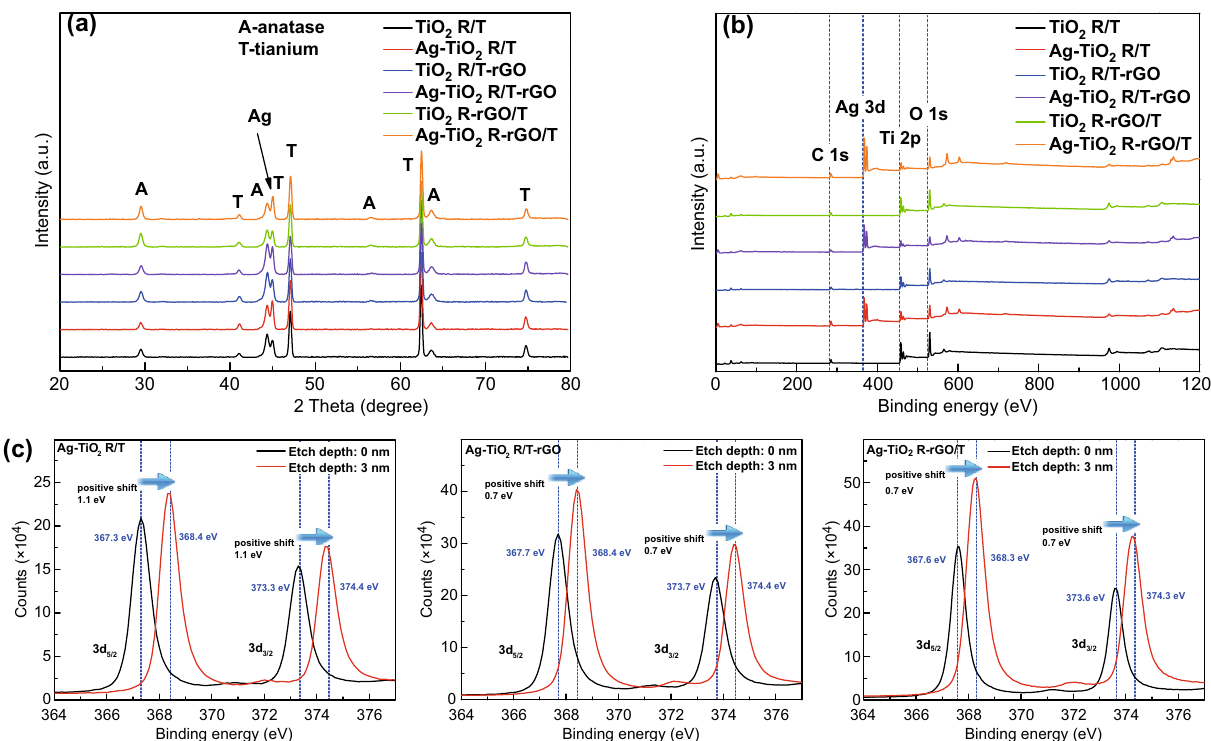
Fig. 1 a XRD patterns, b XPS full spectrum scanning, and c high-resolution XPS spectra of the Ag 3d peaks of TiO 2 -based